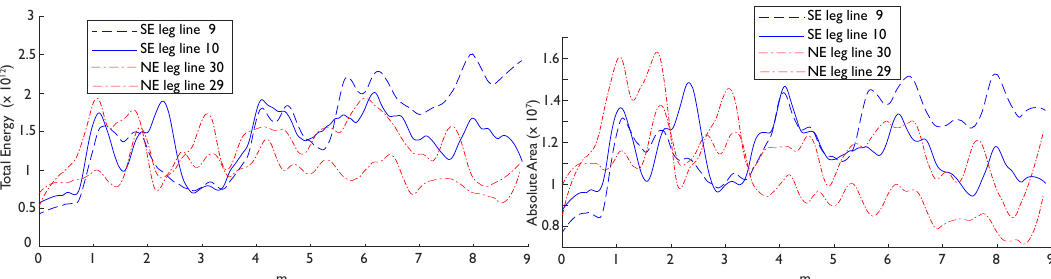
Figure 7. Propagation attributes (smoothed): total energy ( left ) and absolute area ( right ) of the two construction phases, the SE leg (blue solid and large dash) and NE leg (red dotted), show the distinction between the two concrete mixes for two representative pairs of transects at the center of the deck, more pronounced in the energy attribute than absolute area. Table 2. Mean normalized amplitude and propagation attributes (from truncated data) for three pairs of transects: two in the center (10 and 29, 9 and 30) and towards the edge (16, 23). Transect Maximum Maximum Absolute Amplitude Absolute Area Total